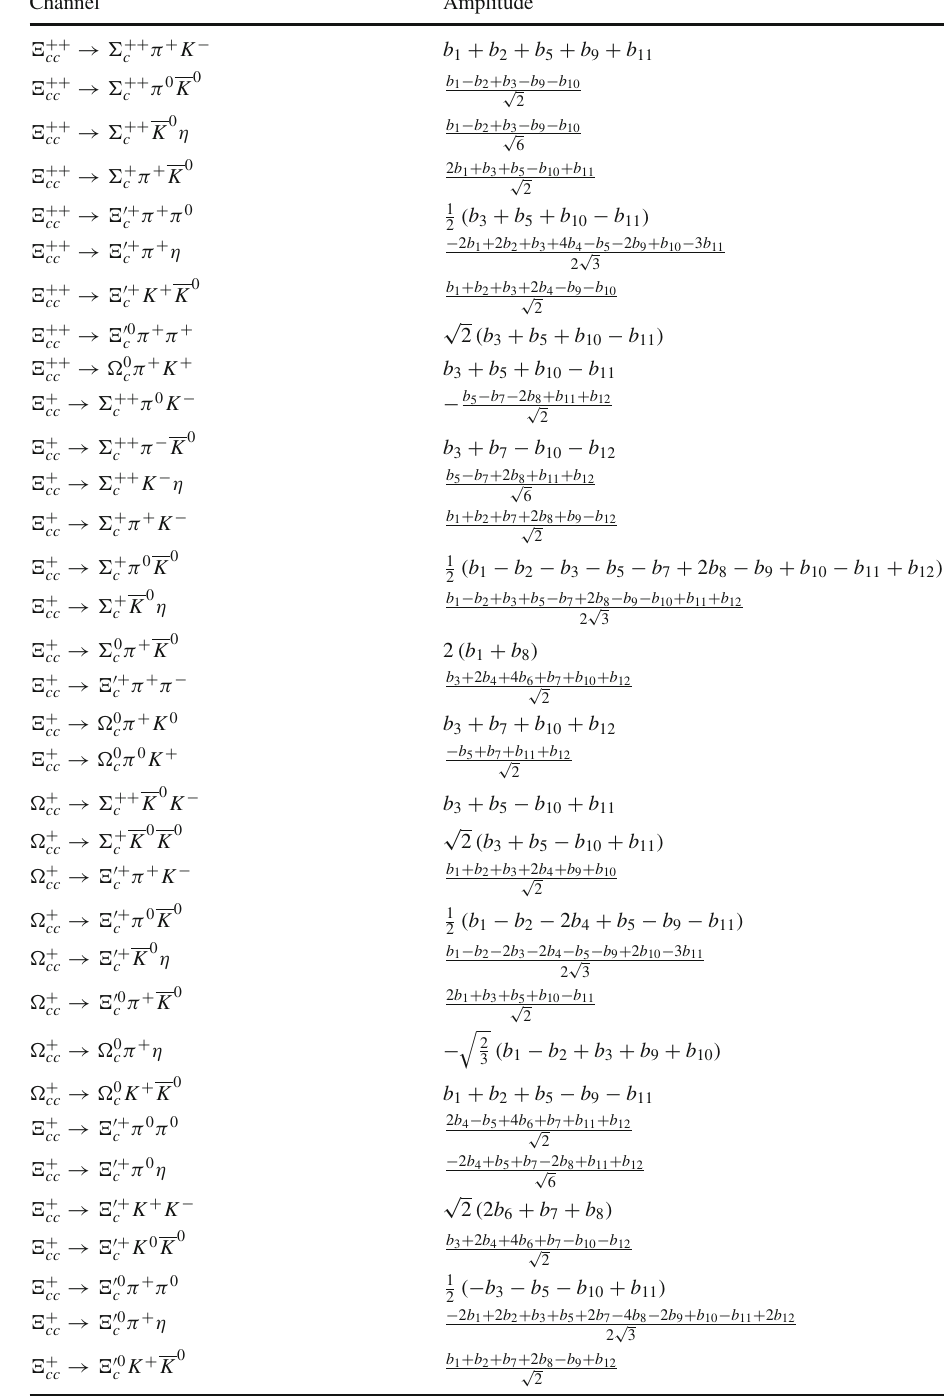
Table 8 Doubly charmed baryon decays into a sextet cqq and two light mesons